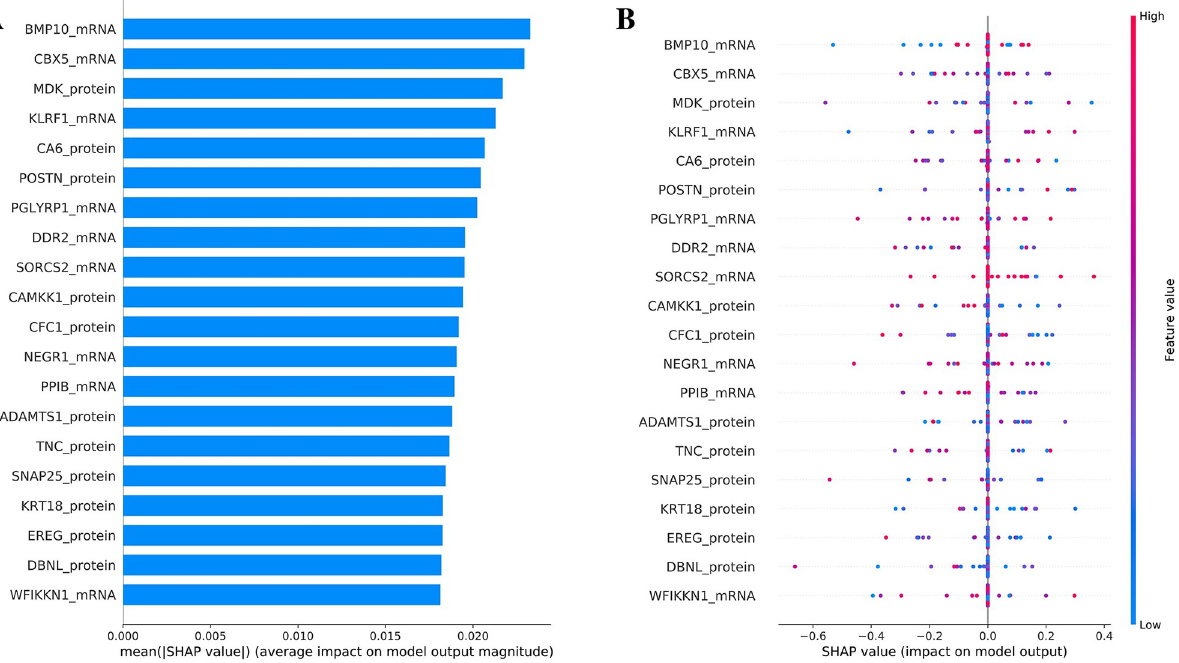
Fig 6. Top 20 important features identified with SHAP values. The SHAP values were calculated on the testing dataset with 1200 samplings. The feature importance is evaluated based on the average absolute SHAP values over subjects. The top important features are ranked in descending order. (A) The horizontal bars show the average impact of a feature on model output magnitude. (B) Impact of top 20 important features on the model output. Each dot represents each subject. The dot color shows whether that feature (variable) is high (in red) or low (in blue) for that observation. The horizontal location shows whether the effect of that value is associated with a higher or lower